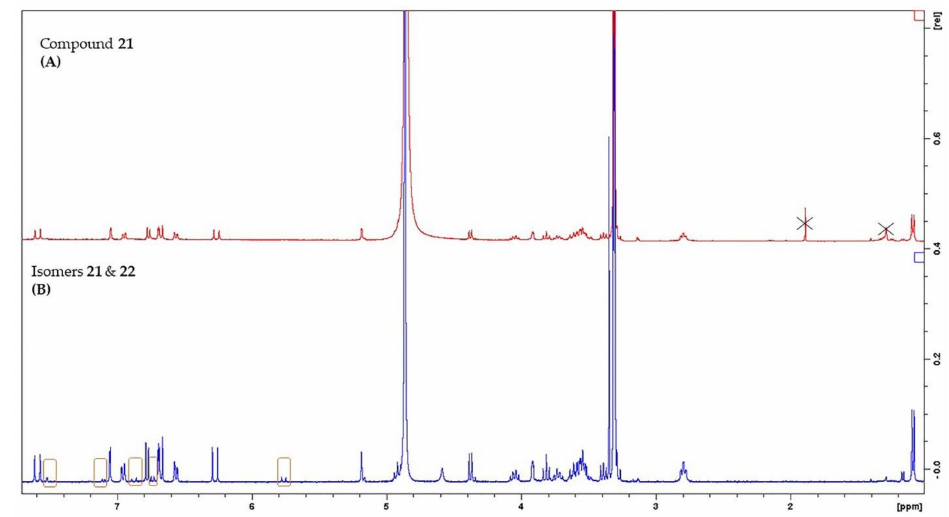
Figure 2. 1 H-NMR spectra of acteoside isomers. ( A ) 1 H-NMR spectrum of trans -acteoside (com- pound 21 ), ( B ) 1 H-NMR spectrum of the mixture of trans -acteoside (compound 21 ) and cis -acteoside (compound 22 ). The major points of differences of the two isomers were signed in orange boxes.